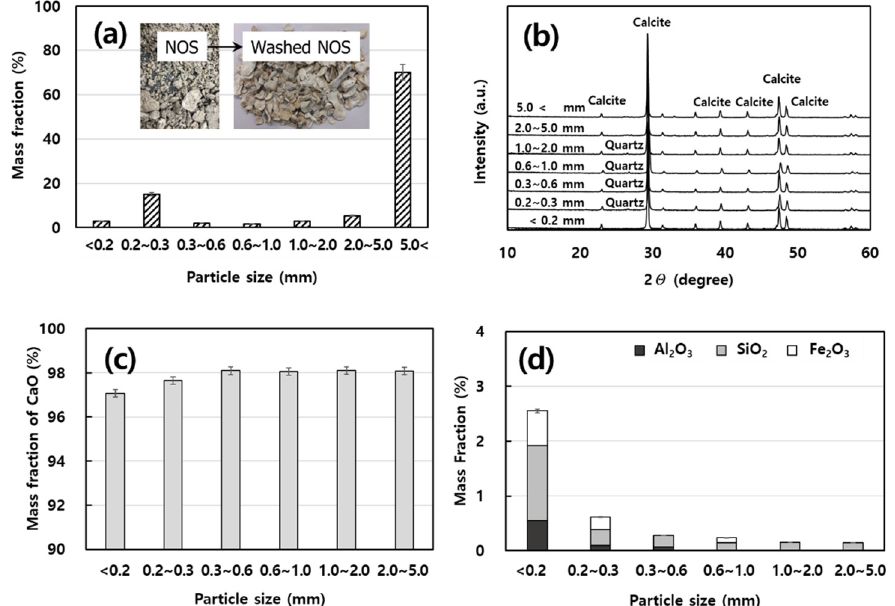
Figure 6. Properties of particle size of washed neglected oyster shells (NOSs). ( a ) Particle size distribution. ( b ) Results of X-ray diffractometer (XRD) analysis of washed NOSs with different particle sizes. ( c ) CaO contents of washed NOSs with different particle sizes. ( d ) Al 2 O 3 , SiO 2 , and Fe 2 O 3 contents of washed NOS with different particle sizes.